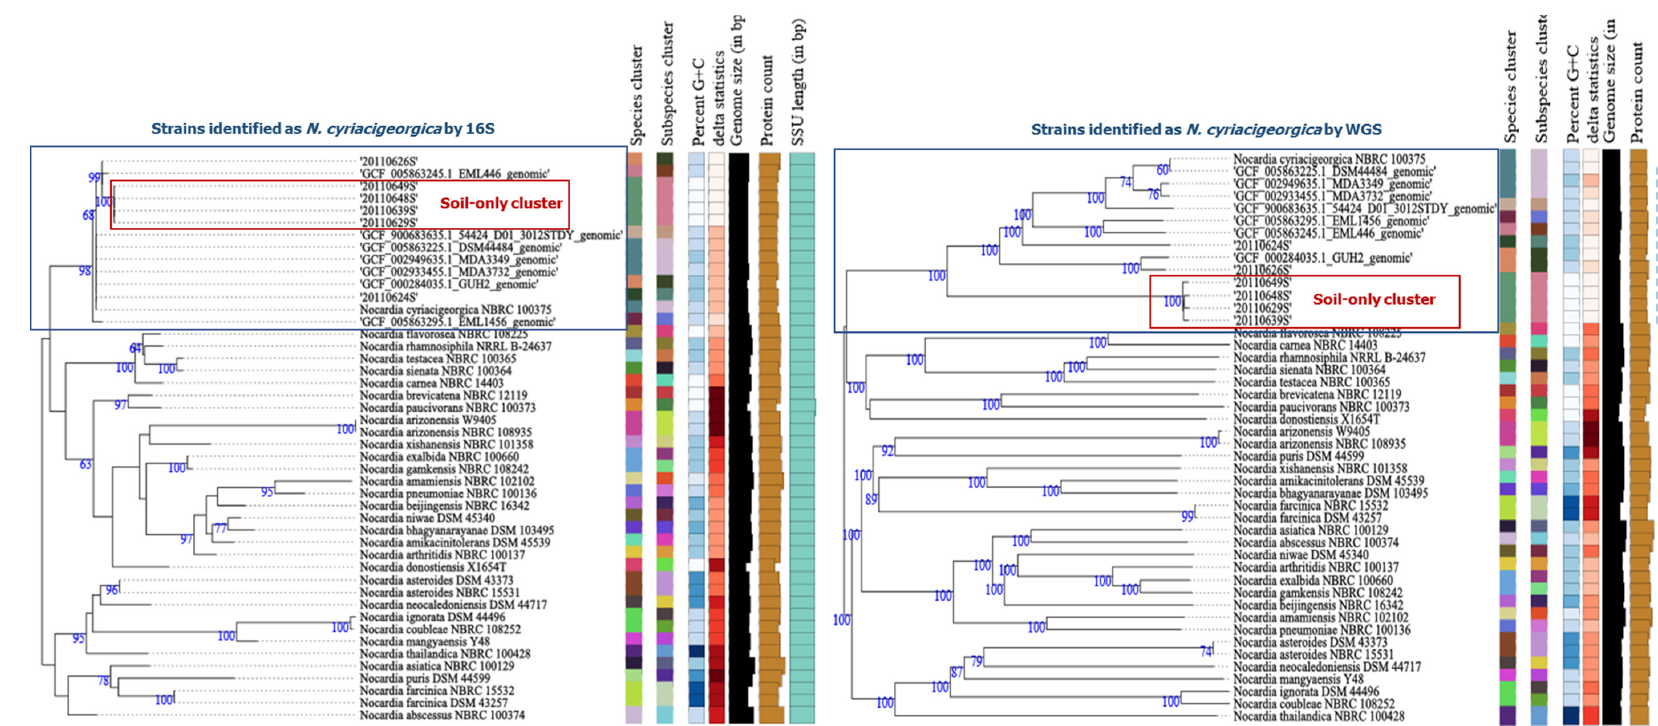
Figure 4. 16S rRNA gene sequence ‐ based and whole ‐ genome sequence ‐ based phylogenetic trees constructed using FastME v.2.1.6.1 software (which calculates Genome BLAST Distance Phylogeny (GBDP) distances; the branch lengths are scaled in terms of GBDP distance formula). The numbers above the branches are GBDP pseudo ‐ bootstrap support values (all are >60% from 100 replications), with average branch support of 91.8% and 58.8% for the 16S rRNA gene and for the genome respectively. The trees were rooted at the midpoint. The results were provided by the Type Strain Genome Server (TYGS), a free bioinformatics platform available at https://tygs.dsmz.de (The whole genome ‐ based taxonomic analysis was performed on 8th January 2020) [39].